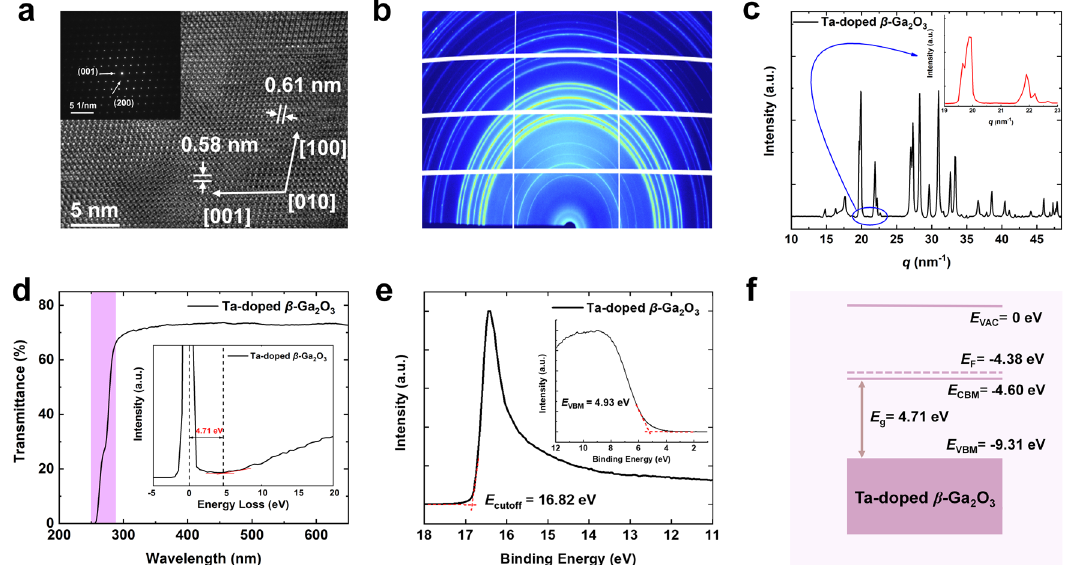
Fig. 1 Material characterizations of Ta-doped β -Ga 2 O 3 . a The HR-TEM image of the exfoliated Ta-doped β -Ga 2 O 3 fl ake. Inset: the SAED pattern of the exfoliated Ta-doped β -Ga 2 O 3 fl ake. b 2D-GIXRD pattern of the Ta-doped β -Ga 2 O 3 . c The integrated 1D-GIXRD spectrum of the Ta-doped β -Ga 2 O 3 . d The transmittance spectrum of the Ta-doped β -Ga 2 O 3 bulk single crystal. Inset: the REELS spectrum of the Ta-doped e The UPS spectra of the Ta-doped β -Ga f The energy band diagram of the Ta-doped β -Ga β -Ga 2 O 3 . 2 O 3 . 2 O 3